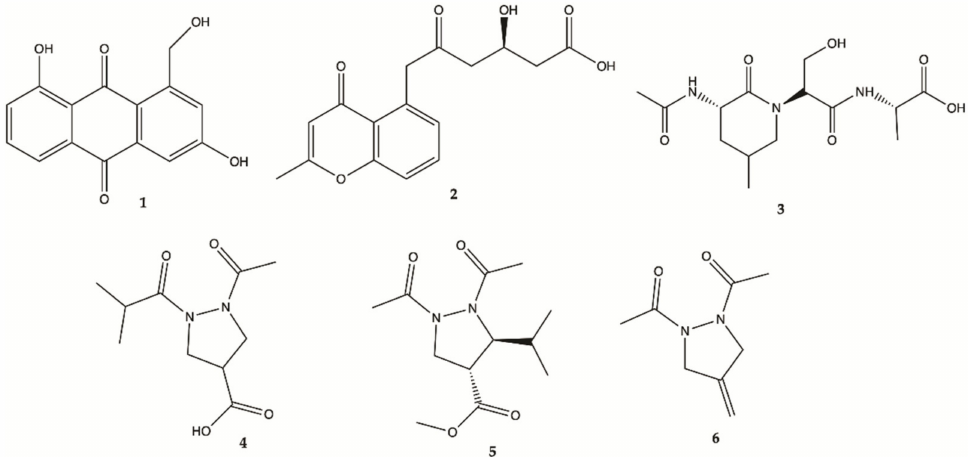
Figure 3. Compounds 1 – 6 isolated from the culture of Streptomyces sp. ZZ406